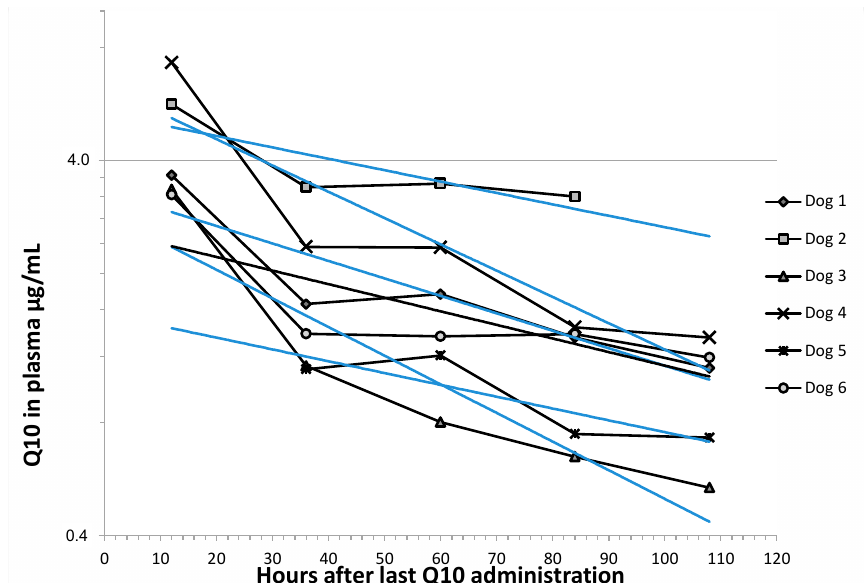
Figure 3. Elimination curves of plasma total Q10 against time. The plot shows plasma concentration of total Q10 in six dogs after 12, 36, 48, 60, and 72 h after the last treatment with Q10 (time 0) on a semilogarithmic scale.